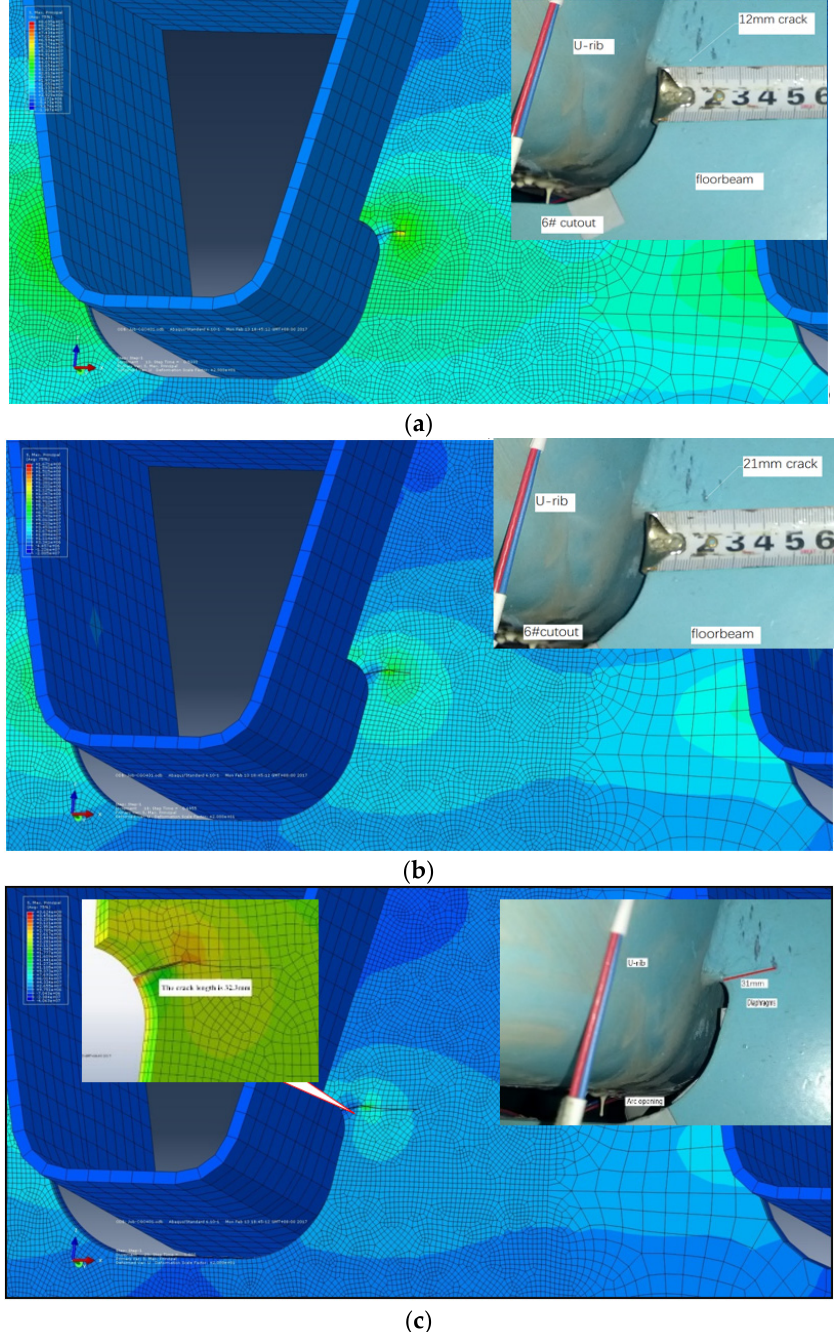
Figure 8. Comparison of simulated crack-propagation and test photos, the top left is the test crack. ( a ) Simulation and experimental comparison of 12 mm crack; ( b ) simulation and experimental comparison of 21 mm crack; ( c ) simulation and experimental comparison of 31 mm crack.